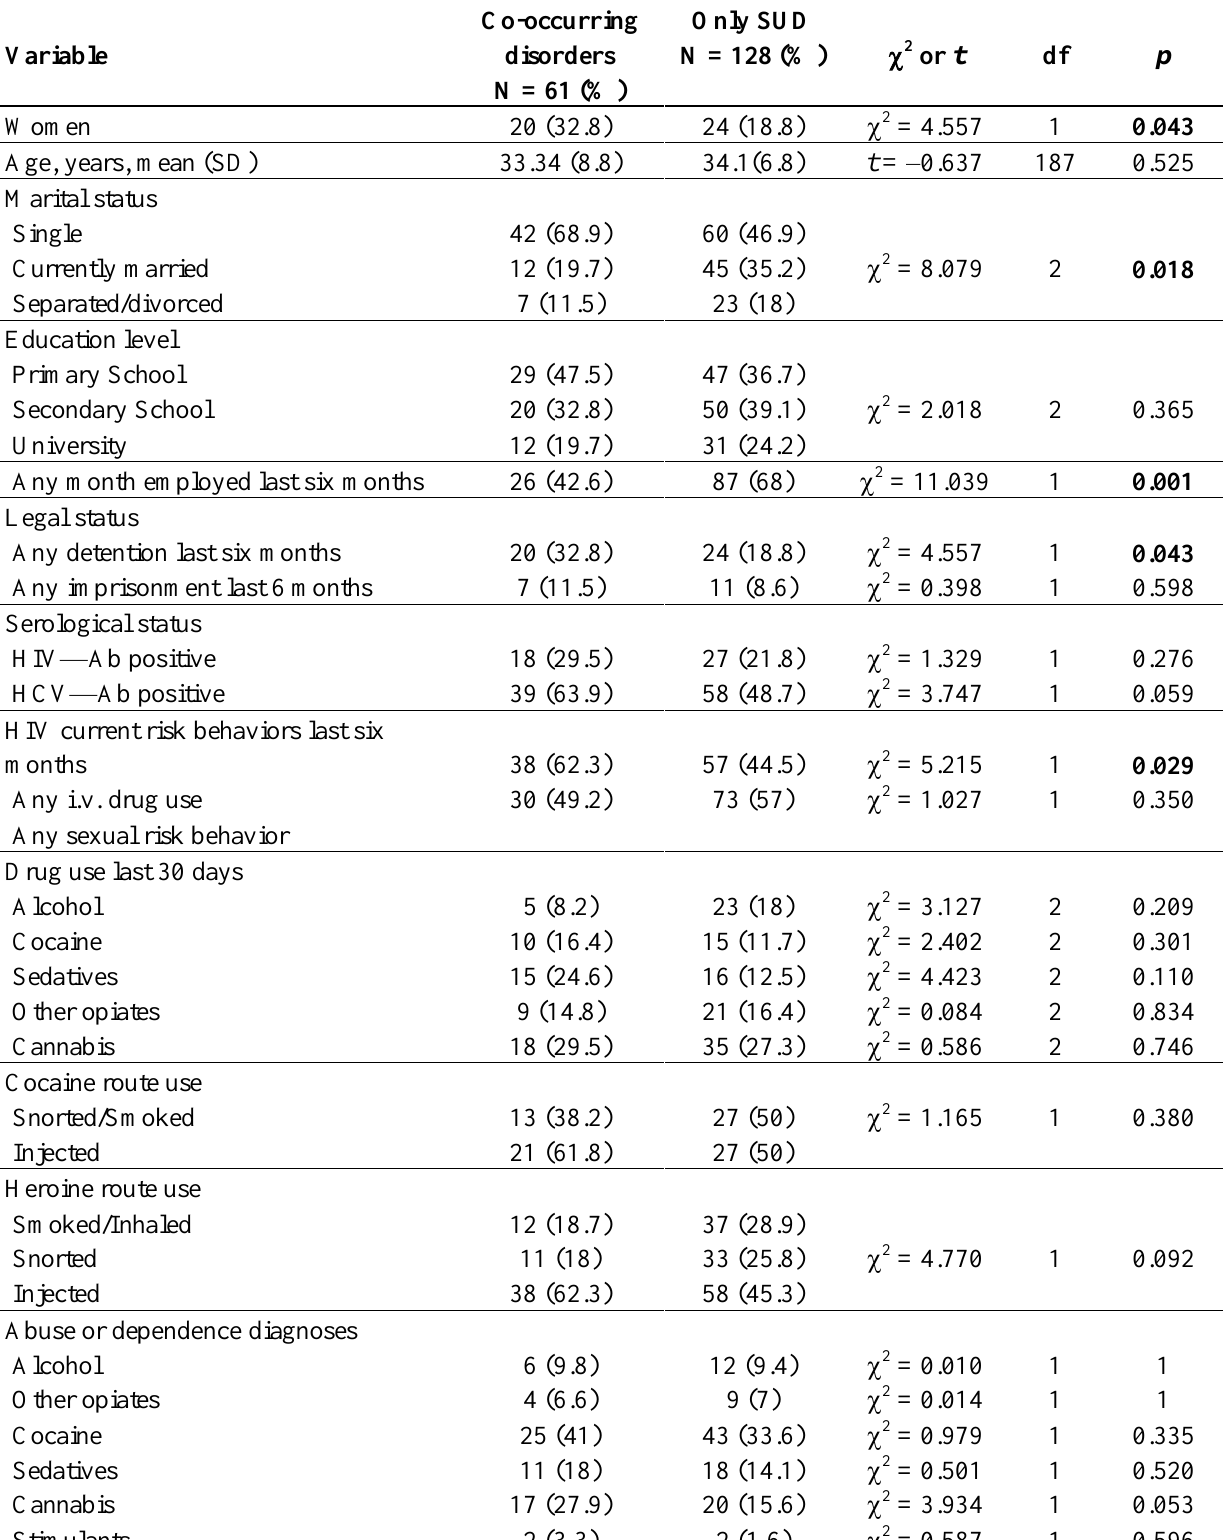
Table 1. Differences between patients with/without co-occurring disorders at